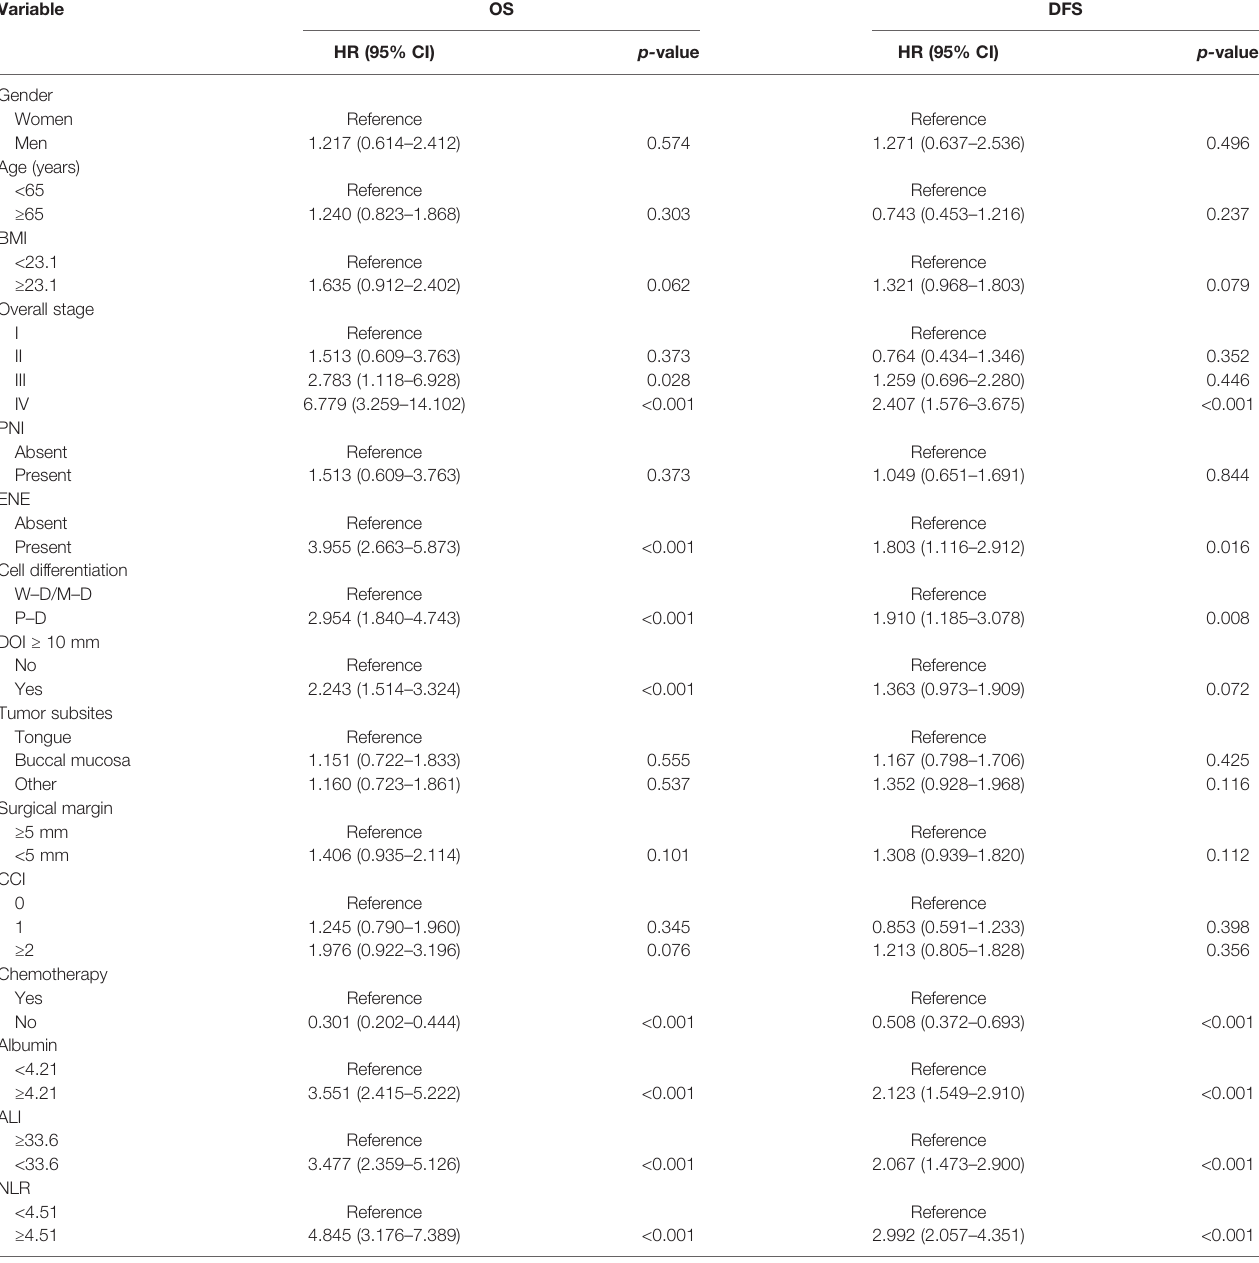
TABLE 4 | Univariate analysis of poor prognostic factors for OS and DFS in OSCC patients.